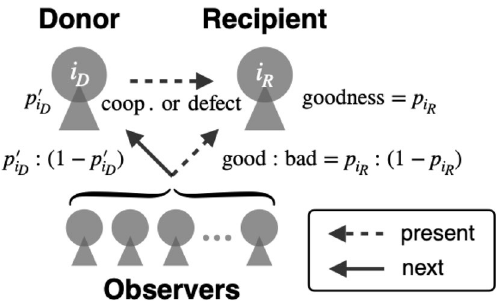
Figure 1. Schematics of indirect reciprocity with private reputation. In every round, a donor ( i D ) and a recipient ( i R ) are randomly chosen. A goodness of the recipient in the present round is given by p i words, the recipient’s reputation in the eyes of a random observer is good (resp. bad) with probability p i p i (resp. 1 ). The donor chooses cooperation (resp. defection) with the recipient if the recipient’s reputation R − in the eyes of the donor is good (resp. bad). After the interaction, each observer independently assigns a new reputation to the donor by taking into account whether the donor took cooperation or defection and whether the recipient’s reputation in the eyes of that observer was good or bad before the interaction. As a result, the goodness of the donor is updated to p ′ i D